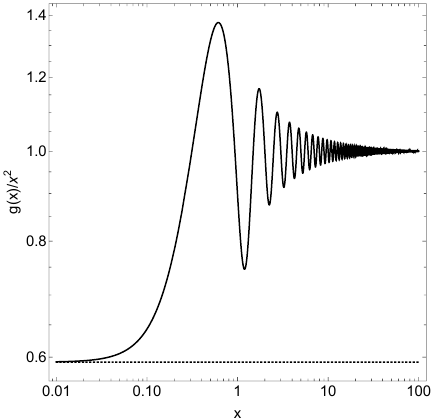
Figure 5 . The rescaled density of states g ( x ) =x 2 with x = !R a . The dotted line corresponds to g 0 = 27 =